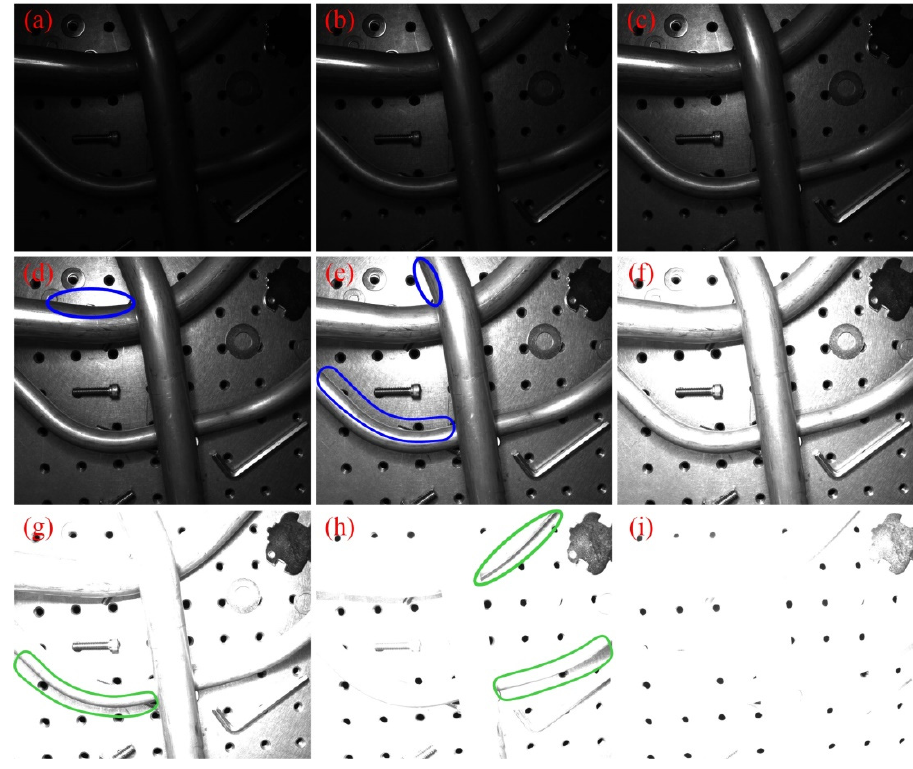
Figure 5. A sequence of tube ME images with different exposure times. ( a ) 2048 μ s; ( b ) 4096 μ s; ( c ) 8192 μ s; ( d ) 16,384 μ s; ( e ) 32,768 μ s; ( f ) 65,536 μ s; ( g ) 131,072 μ s; ( h ) 262,144 μ s; and ( i ) 524,288 μ